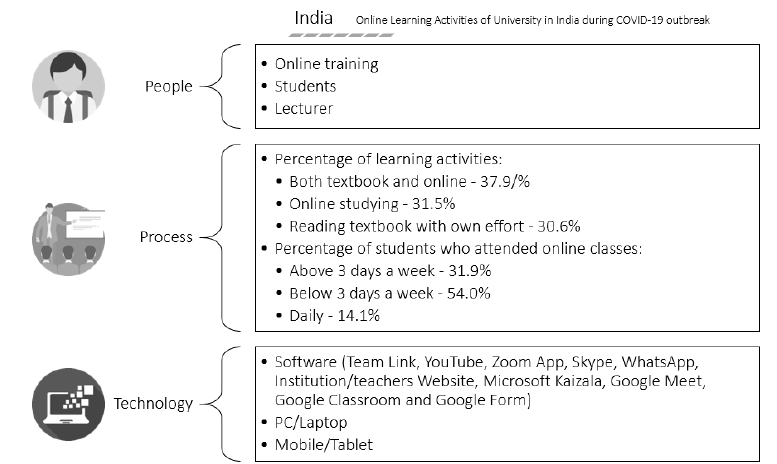
Fig. 6. Online Learning Activities of University in India during COVID-19 outbreak